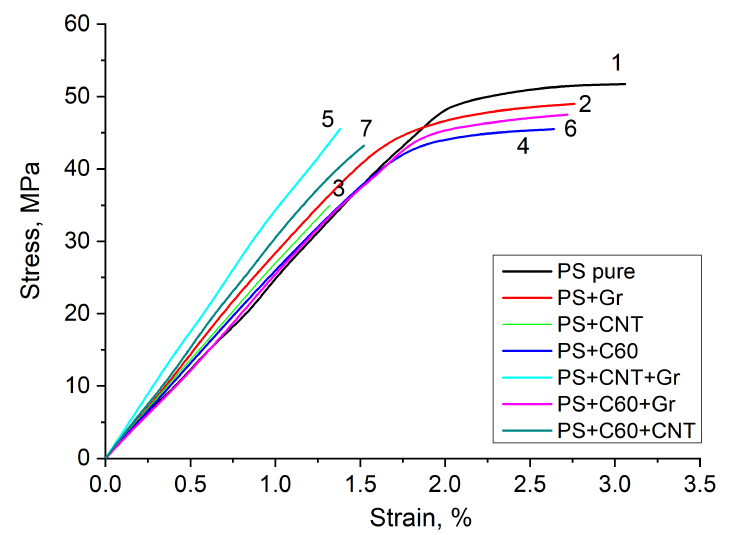
Figure 4. Tensile stress-strain curves of PS-based nanocomposites with the addition of single-type particles (graphene, C 60 and CNT) and binary mixtures (graphene + C 60 , C 60 + CNT, CNT + graphene): 1—PS